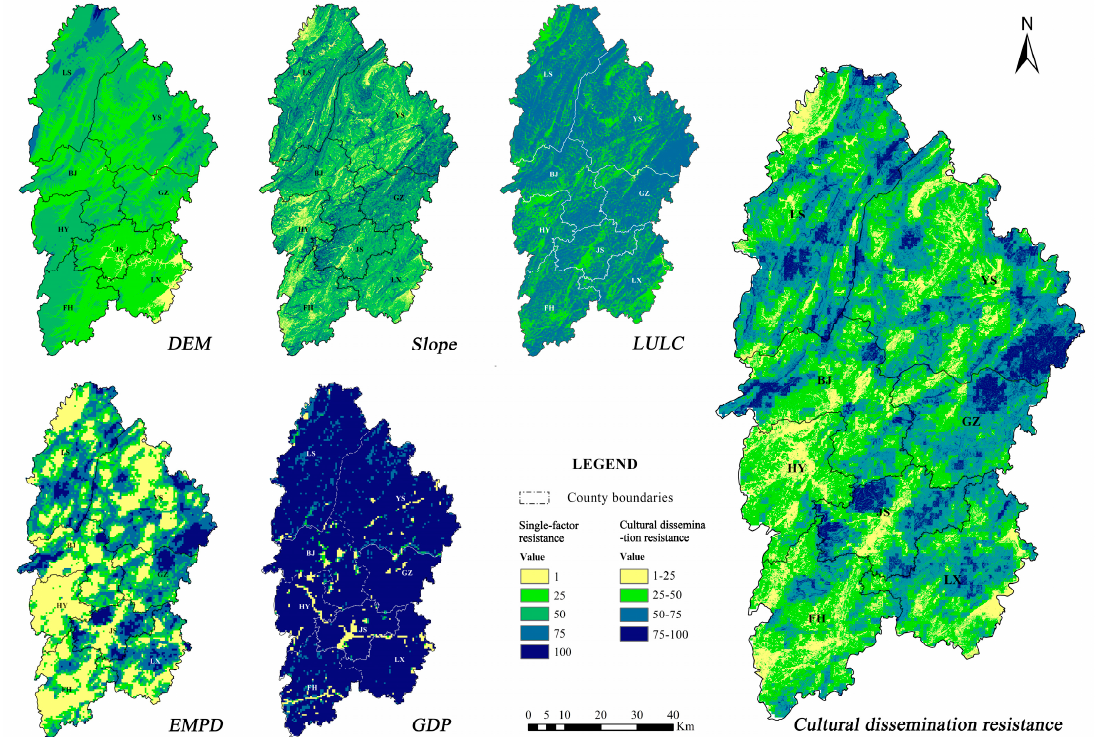
Figure 3. The distribution map of single-factor resistance and cultural dissemination resistance. LS, YS, BJ, GZ, HY, JS, LX, and FH represent Jishou City, Longshan County, Yongshun County, Baojing County, Guzhang County, Huayuan County, Luxi County, and Fenghuang County in Xiangxi Prefecture, respectively.